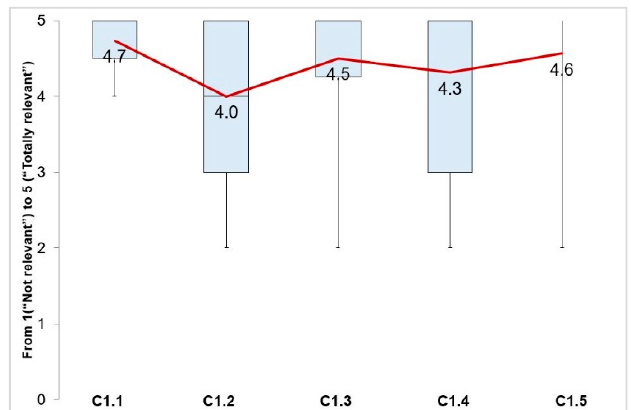
Figure 1. Relevance level (average and range) of global factors in the pre-installation phase.